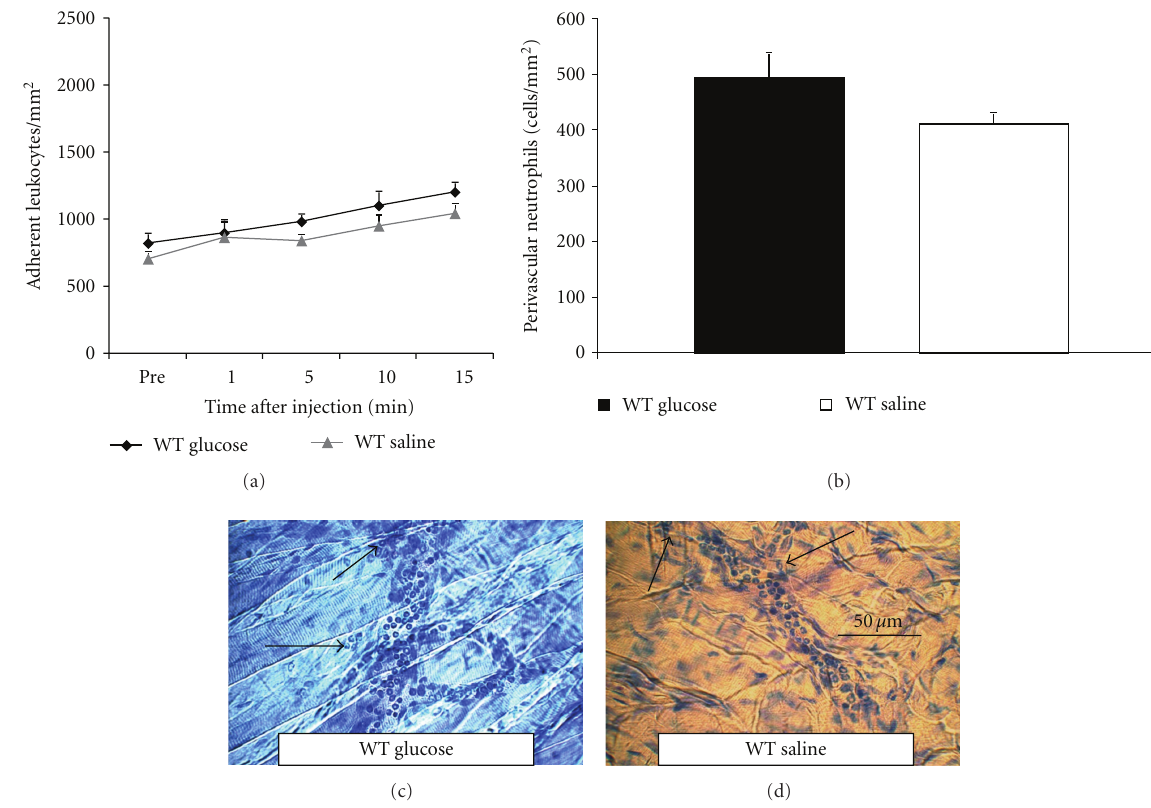
Figure 2: Leukocyte adhesion (number of adherent cells/mm 2 ) in mouse cremaster muscle venules and leukocyte transmigration (perivascular neutrophils/mm 2 surface area) in cremaster muscle whole mounts in response to glucose during TNF α -induced inflammation. (a) Leukocyte adhesion was observed in TNF α -stimulated cremaster muscle venules of wild-type mice (17 venules in 5 mice) before and during 15 minutes after intravenous injection of 0.5g/kg glucose and compared to injection of normal saline (9 venules in 4 mice). (b) Giemsa-stained whole mounts of TNF α -treated cremaster muscles of WT mice were analyzed for the number of perivascular neutrophils after injection of glucose or normal saline. Representative micrographs are depicted in Figures 2(c) and 2(d). Reference bar is presented in Figure 2(d). Arrows point to extravasated leukocytes. All values are presented as mean ± SEM. Significances are indicated by the asterisks ( ∗ P < 0 . 05 versus WT control